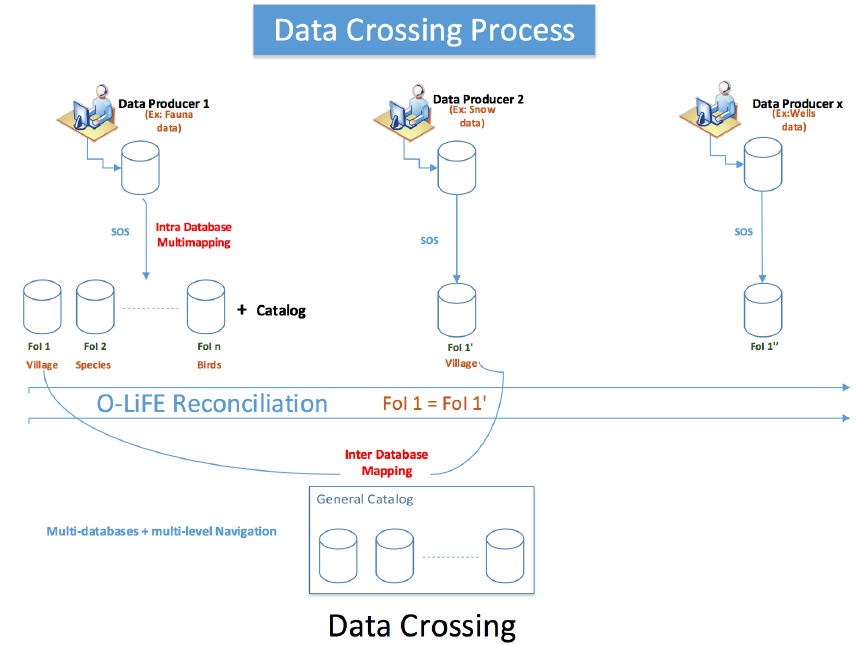
Figure 2. Complete